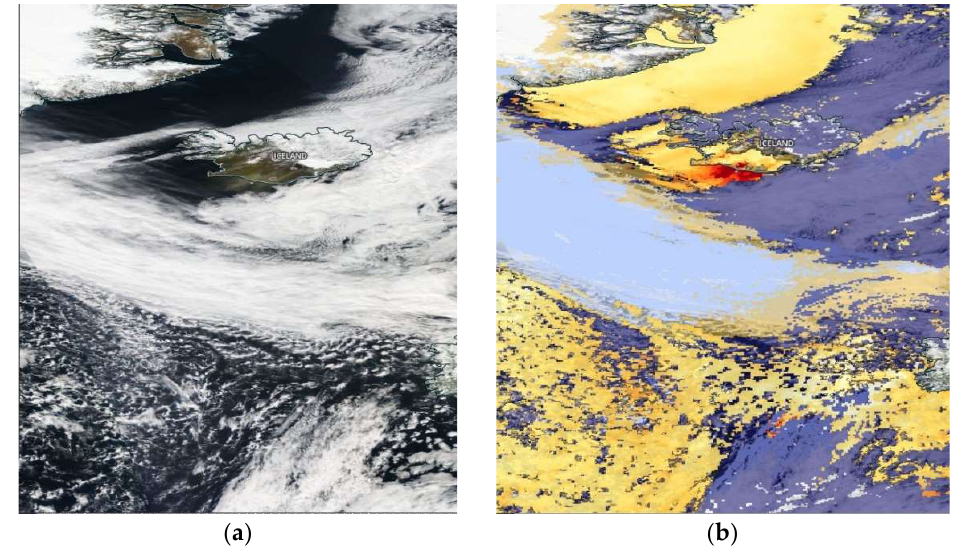
Figure 7. Dust storm event in Iceland on 12 September 2011. Dust plume detected: ( a ) MODIS Terra and Aqua combined corrected reflectance (true color); and ( b ) Aerosol Optical Depth (AOD). A large amount of dust, emitted from a nearby Hagavatan hot-spot and transported by intense N–NE winds, caused an increase in PM 10 concentration at Reykjavik